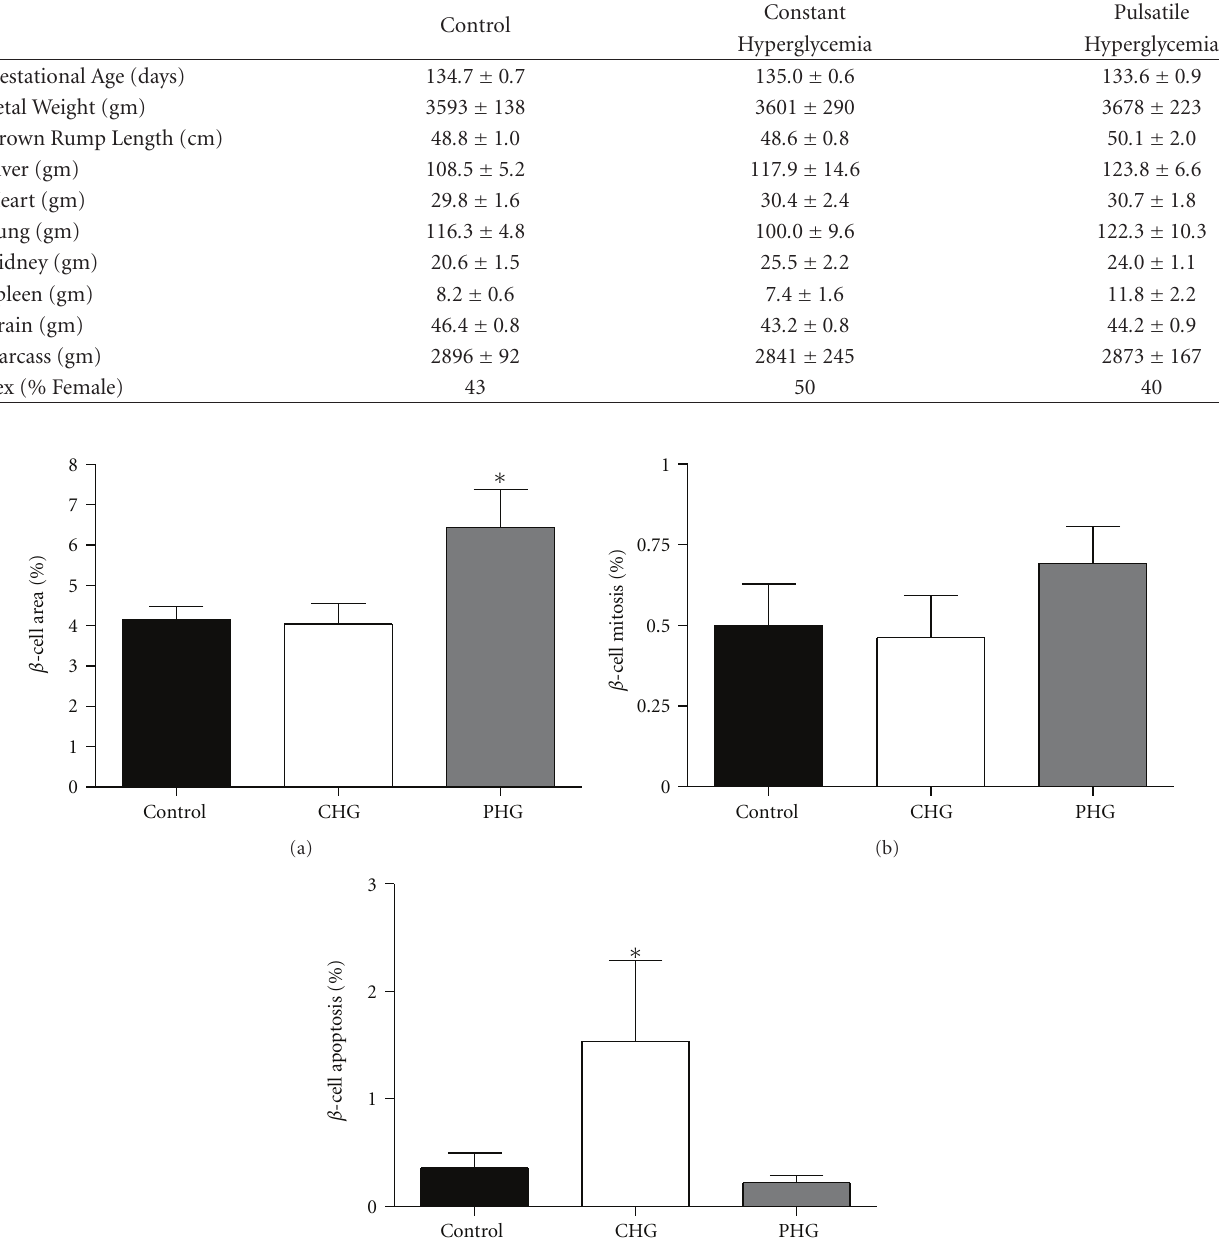
Table 1: Fetal Age, Weights, and Length.